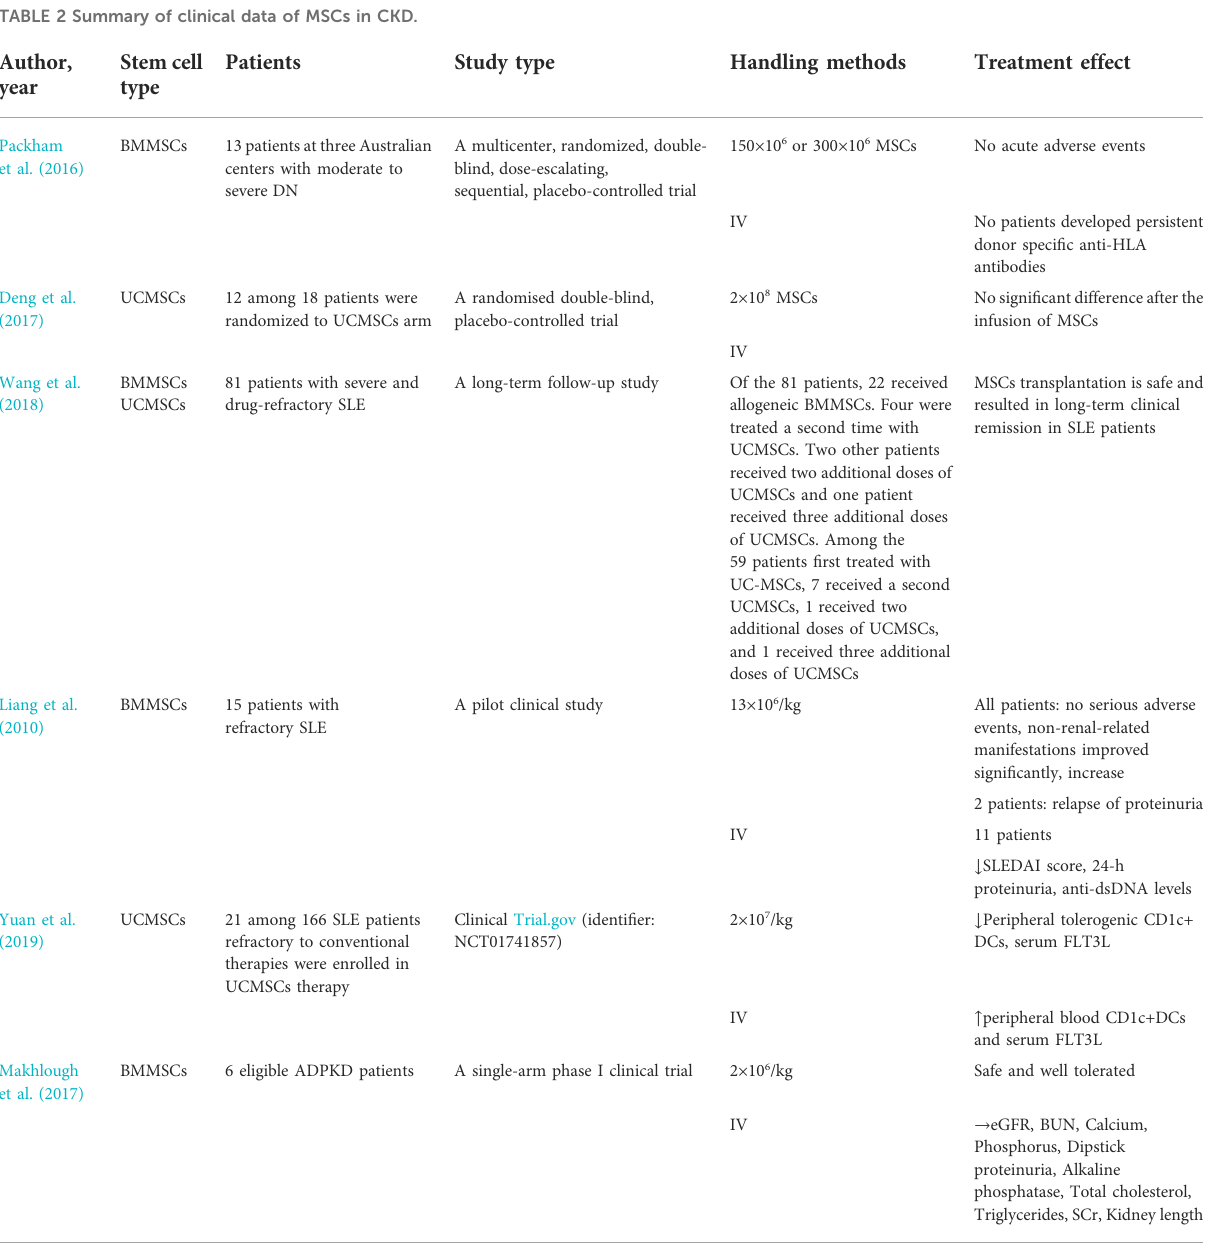
TABLE 2 Summary of clinical data of MSCs in